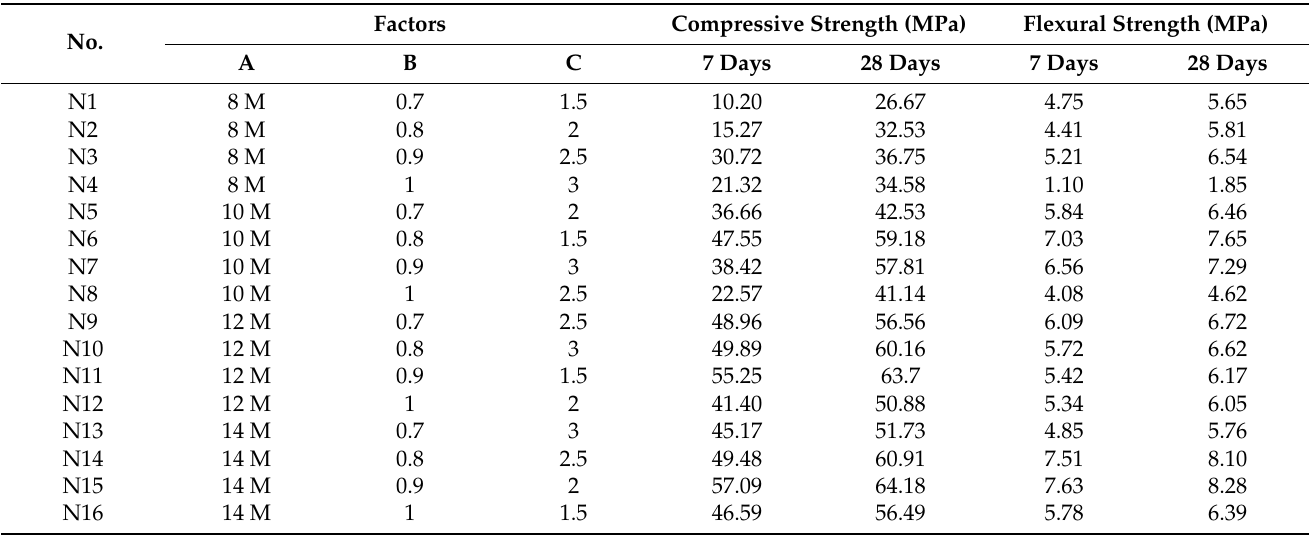
Table 3. The 7-day and 28-day compressive and flexural strengths of the Na-based geopolymers.